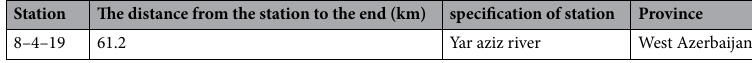
Table 2. Specifications of the input reaches to the main reach.